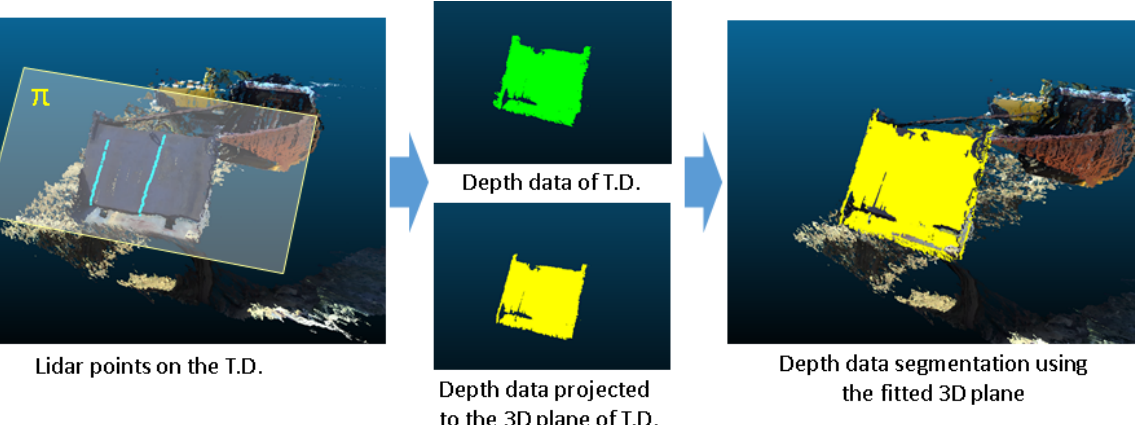
Figure 10. The result of projecting a dense point cloud obtained with a stereo camera onto the equation of the truck’s back plate plane obtained from LiDAR.